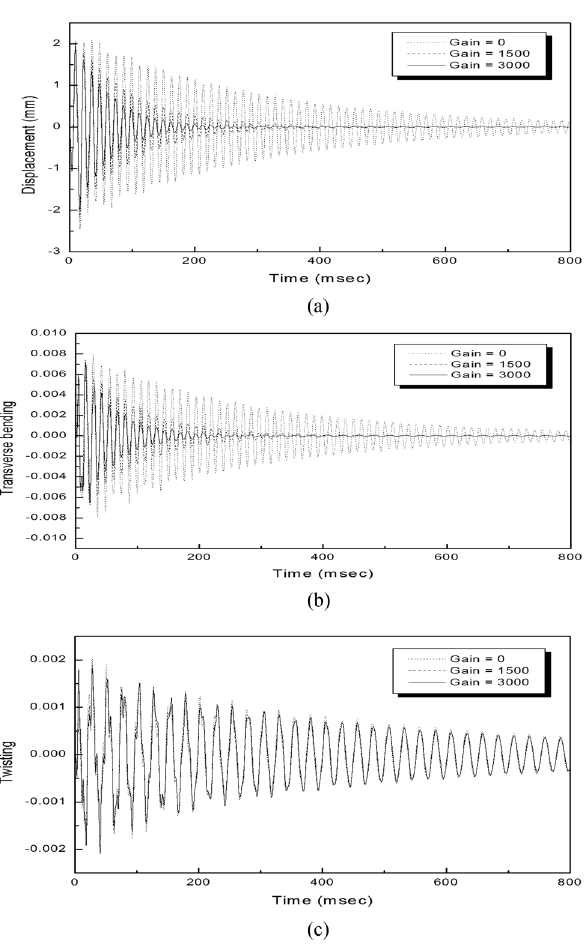
Figure 14: Responses of a sti ff ened plate ( case 3 ) with various control gains: ( a ) vertical displacement, ( b ) transverse bending displacement and ( c ) lateral twisting